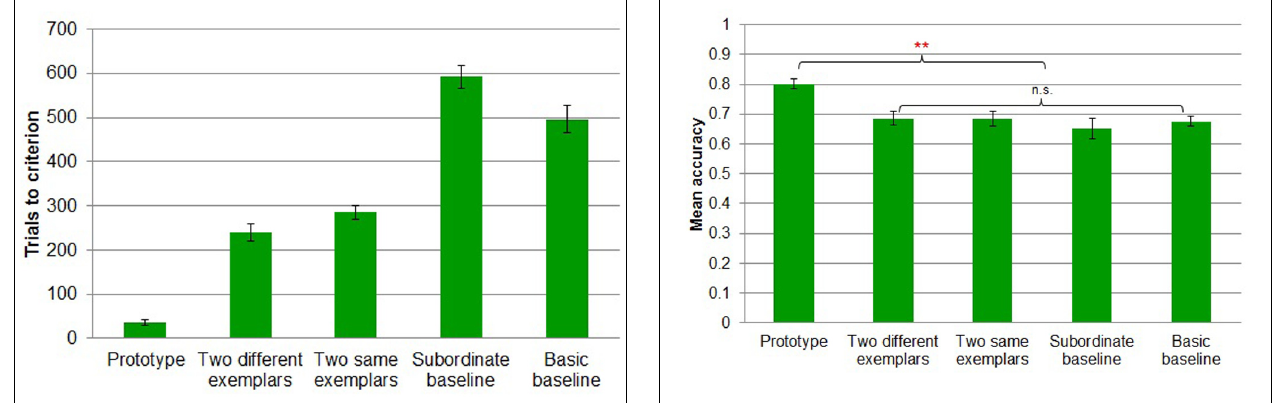
FIGURE 8 |Trials to criterion by study condition in Experiment 3. Error bars represent SEs.